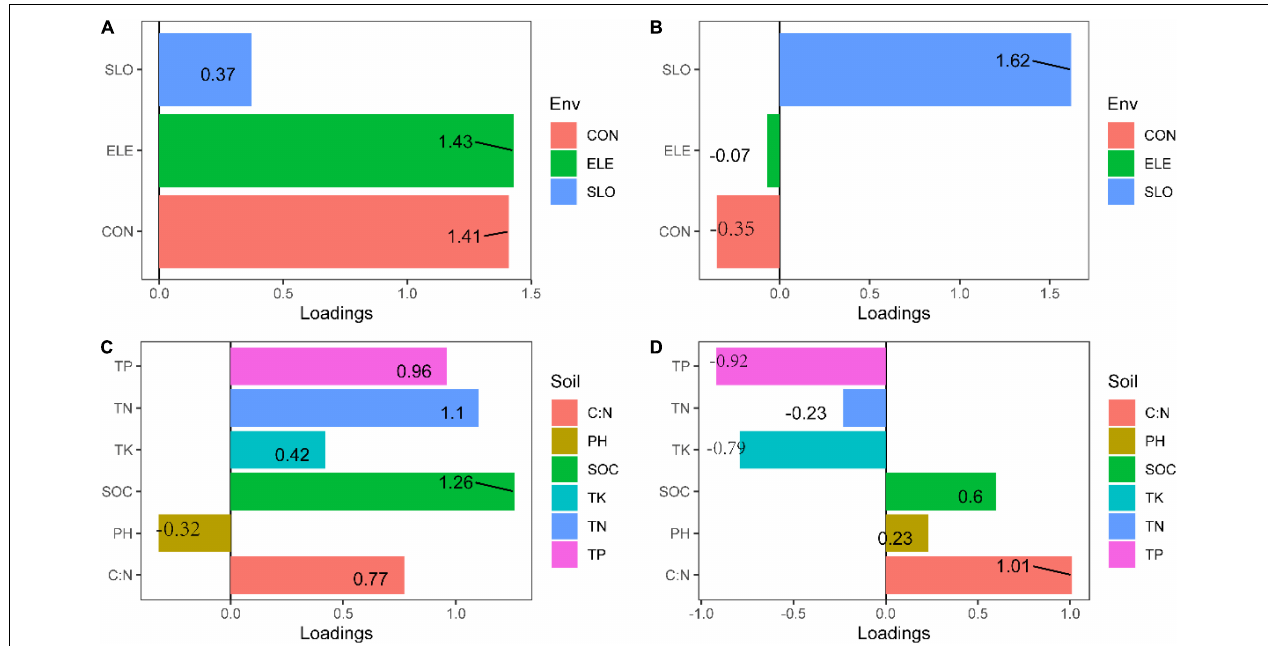
FIGURE 6 | Loadings for the topography and soil properties principal components (PCA) (A) PC 1 for topography, (B) PC 2 for topography, (C) PC 1 for soil properties, and (D) PC 2 for soil